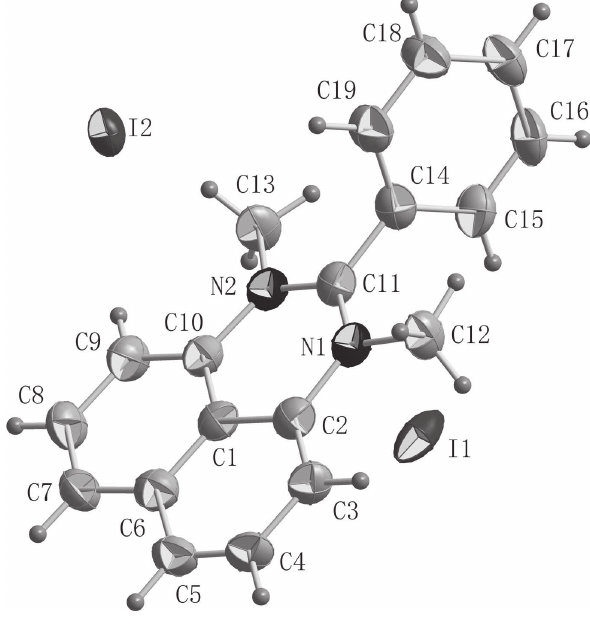
Table 1: Data collection and